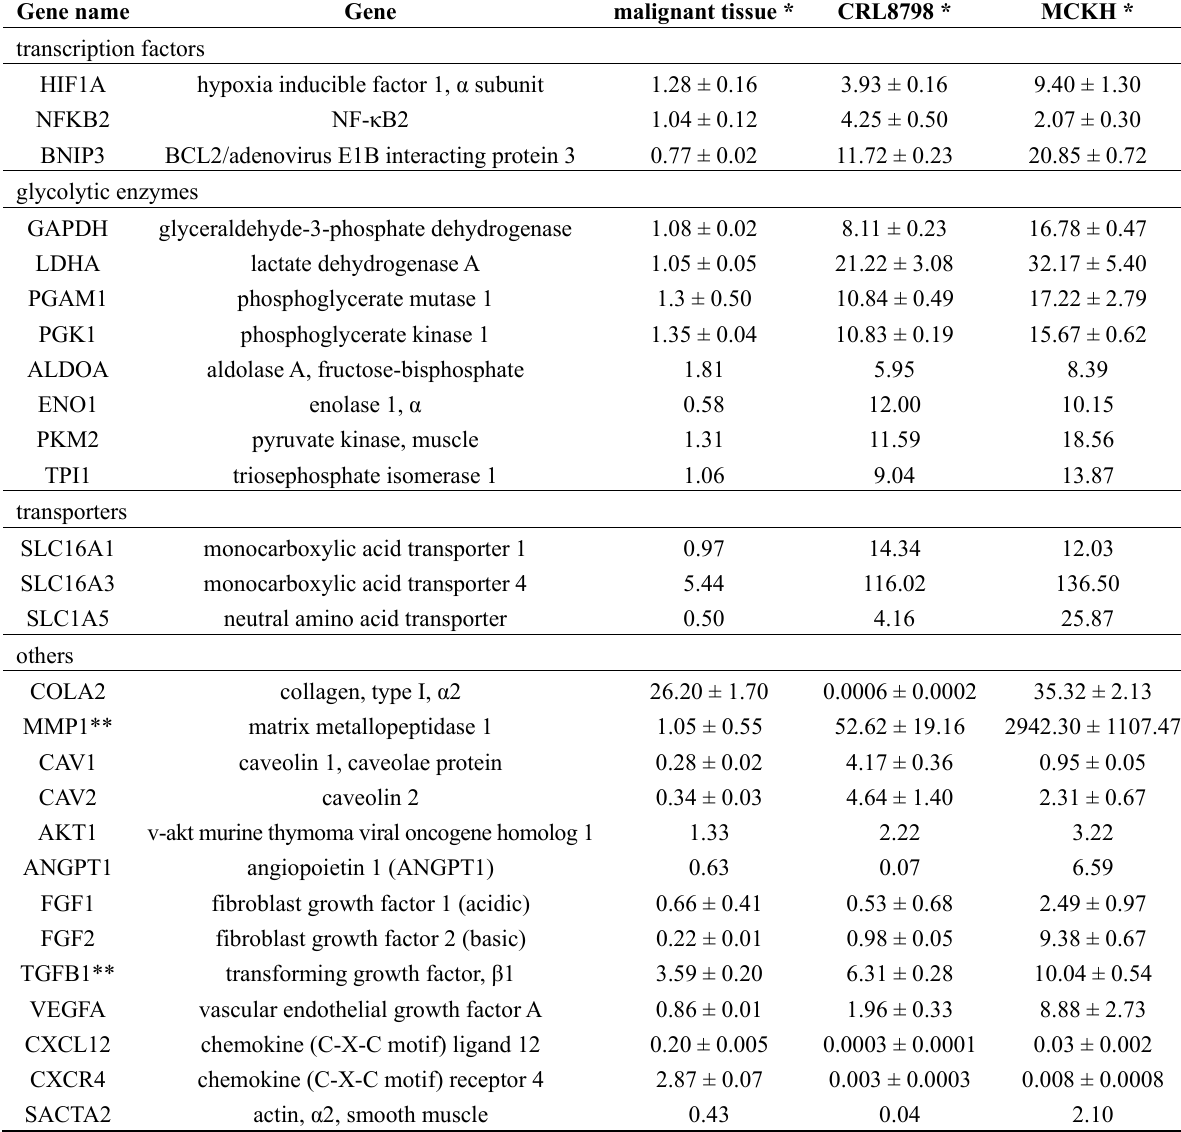
Table 1. Expression profiles of CAF-related genes in MCKH